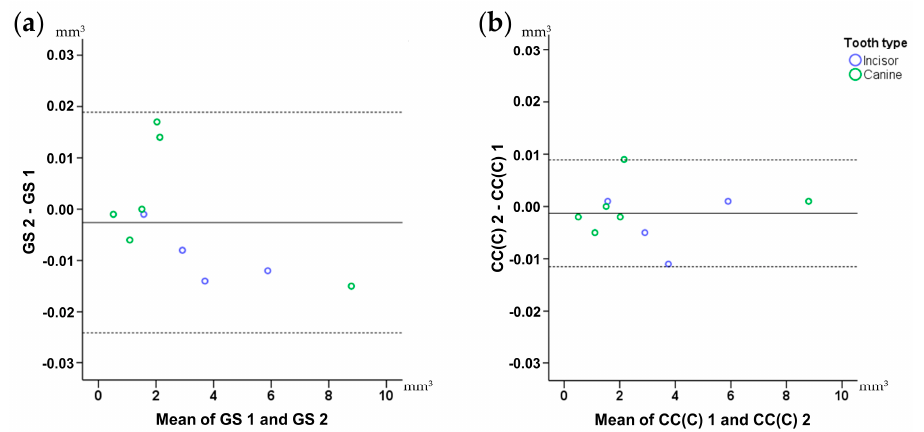
Figure 4. Bland–Altman plots showing intra-operator error on tooth wear volume measurements. ( a ) Gold standard (GS) technique. ( b ) Technique of choice: complete crown (CC) with 20% estimated overlap. The axes length represents the true range of measured tooth wear values. The continuous horizontal line shows the mean and the dashed lines the 95% confidence intervals.